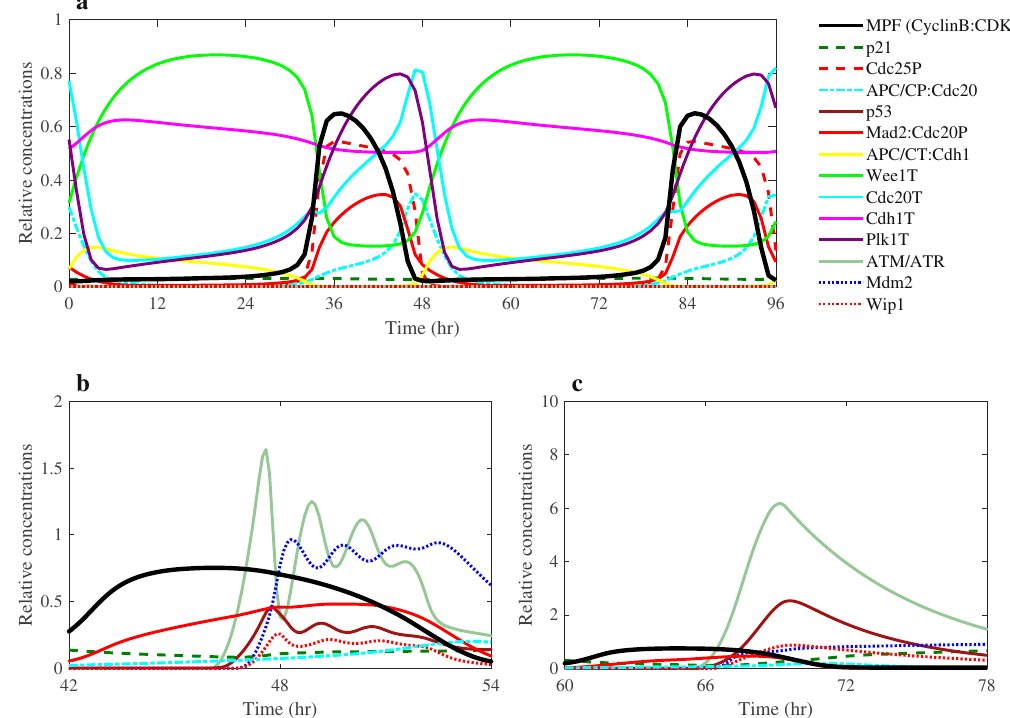
Fig. 2 Numerical simulations of the mitotic cell cycle and G2/M DNA damage checkpoint regulation models. a Dynamic behavior of the mitotic cell cycle and DNA damage checkpoint components. b , c Numerical simulations of protein concentrations in Plk1-depleted cells. Plk1 concentration was reduced by 70% relative to its level in p53-wild-type cancer cells. The depletion of Plk1 induces DNA damage response and prompts the increase in the concentration of related regulators. b ATM, p53, Mdm2, and Wip1 exhibit oscillatory dynamics. c The oscillatory dynamics disappeared when the negative regulation of Wip1 on ATM was disrupted. These simulation results agree with similar observations reported in refs. 32,35 . All concentrations in these plots are expressed relative to CDK1